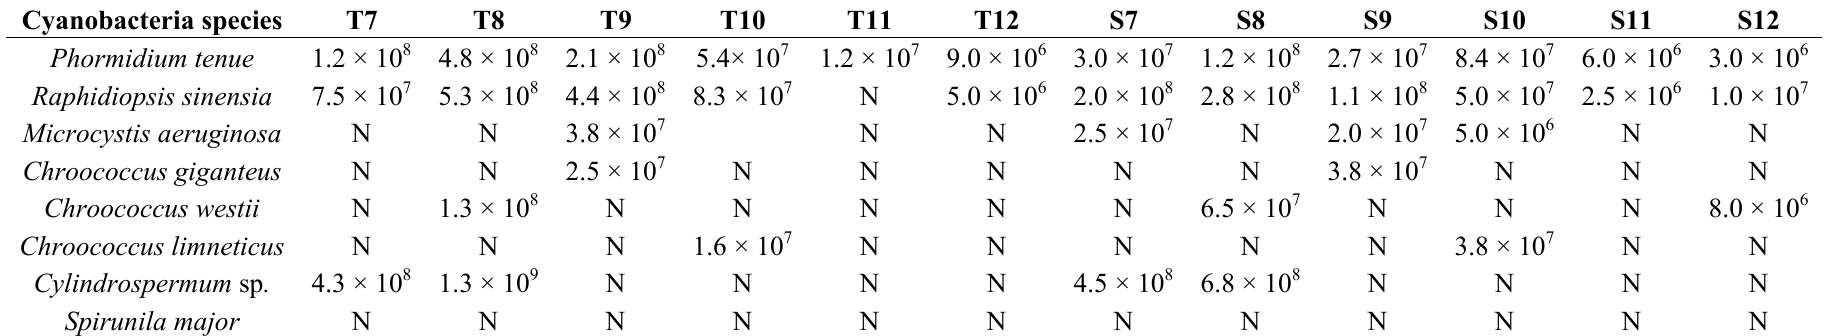
Table 2. Monthly abundance of main cyanobacteria species in Tiegang and Shiyan Reservoirs from July to December, 2007. Cyanobacteria species